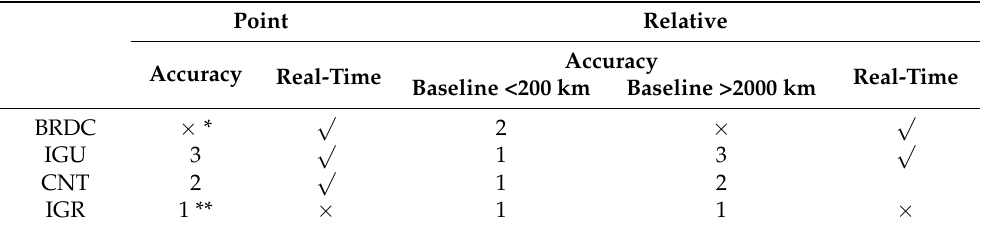
Table 6. Positioning performance of various satellite products in terms of positioning accuracy and the feasibility for real-time applications. Point